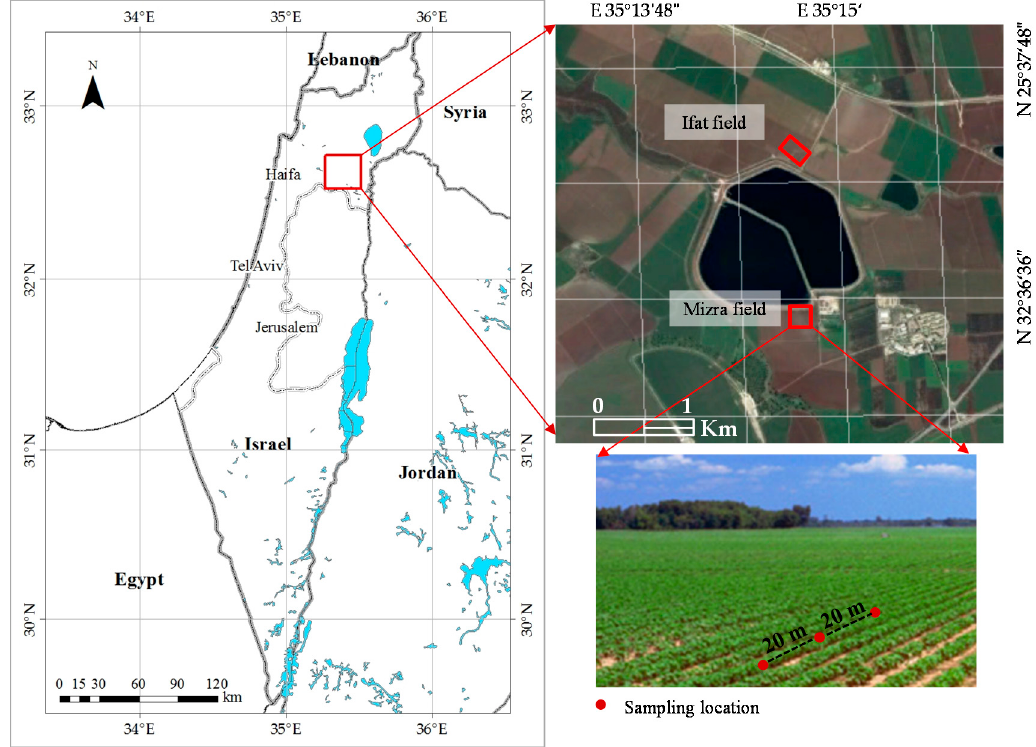
Figure 1. Location of Jezreel Valley on a map of Israel ( left ), with study fields bordering the Genigar Reservoir ( right, top ) and cotton planted in rows in the irrigated field at Mizra ( right, bottom ). Plant sampling locations are marked.